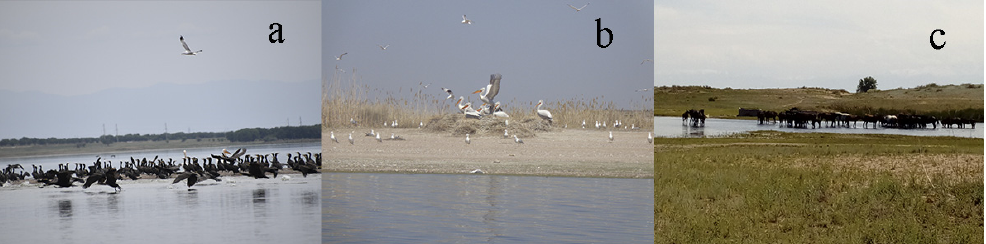
Figure 3. Great cormorant ( Phalacrocorax carbo ) on a sandy spit in the northern part of Sorbulak ( a ), pelican colony ( Pelecanus crispus ) on the island ( b ), animals at the watering place ( c ). Photos by A. Gavrilov and E.